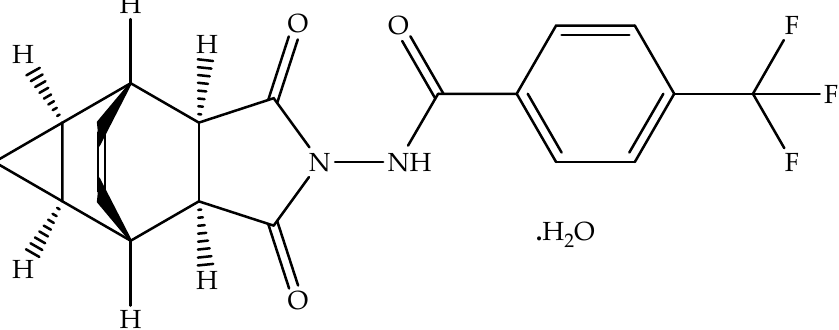
Figure 1. Chemical structure of Tecovirimat monohydrate.